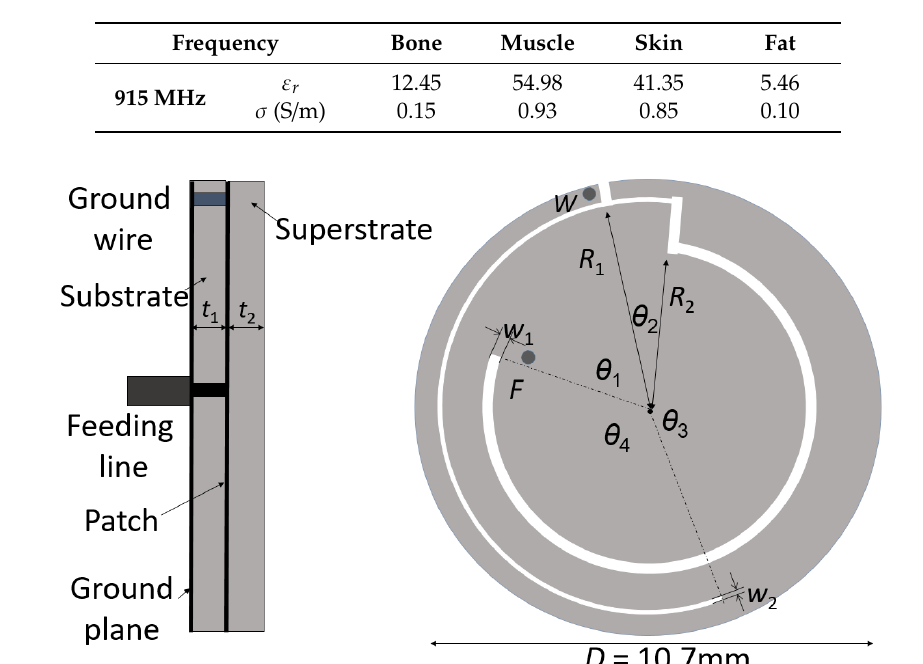
Figure 2. Detailed antenna design. Table 2. Antenna